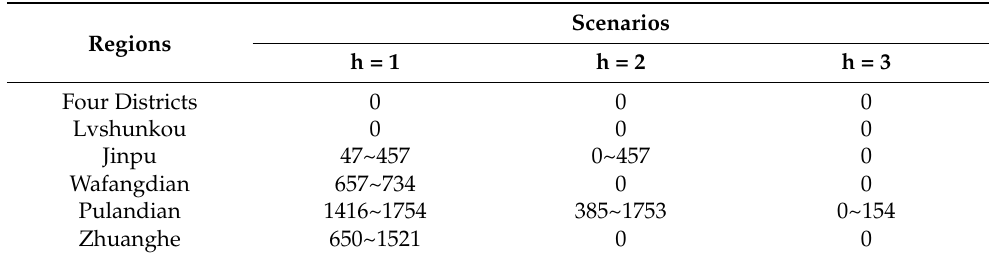
Table 7. Upper and lower bounds of water resource deficit for ecological environment sector under different scenarios in period 1.